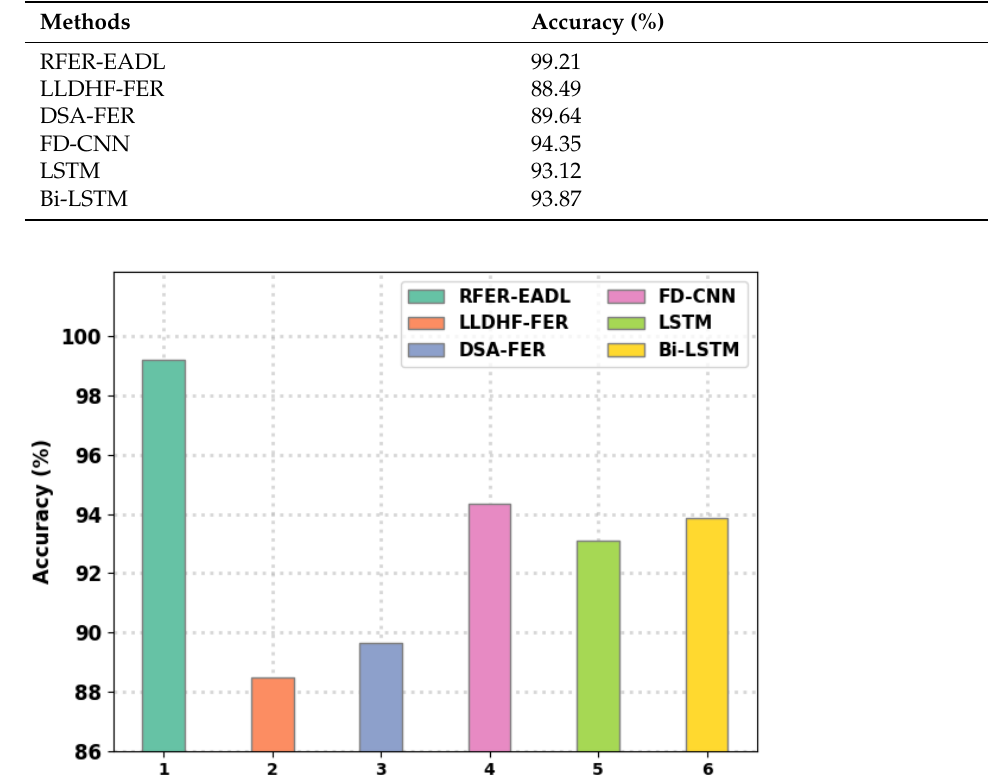
Figure 13. ROC curve analysis of the RFER-EADL algorithm.